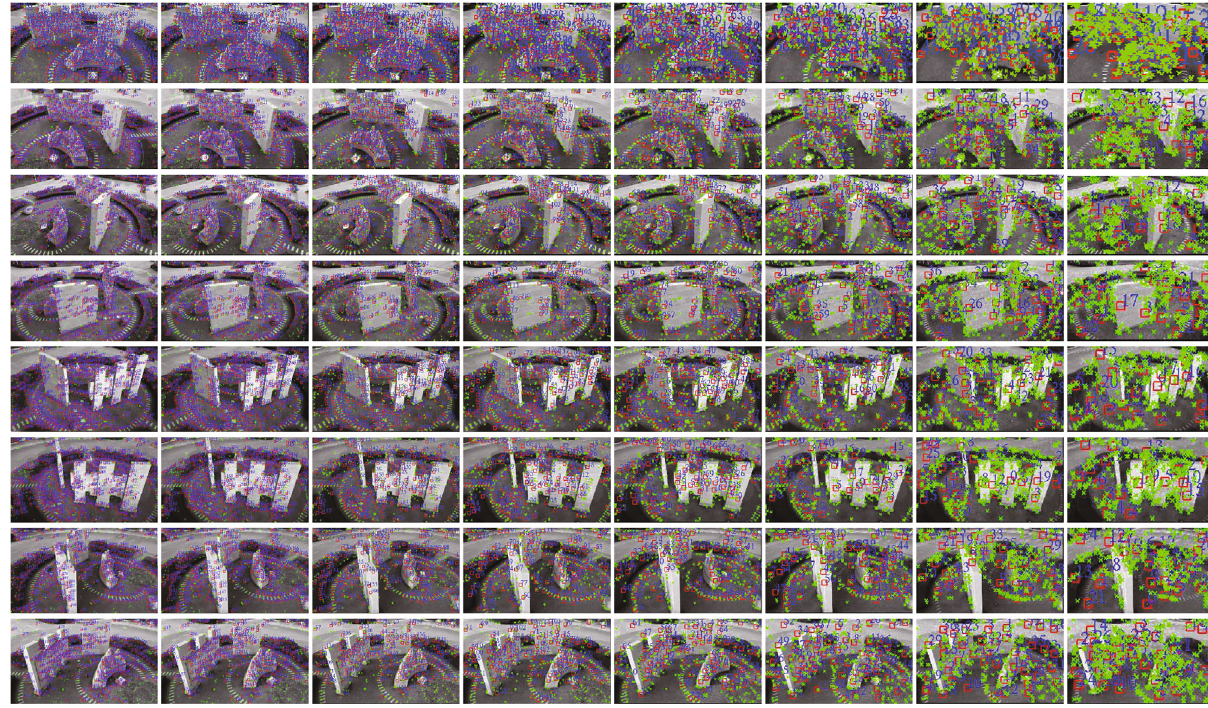
Figure 4: Feature point diagrams at di ff erent resolutions (from left to right, the resolutions are (in DPI) 96.000000, 80.000008, 63.496048, 50.396847, 40.000004, 31.748022, 25.198421, and